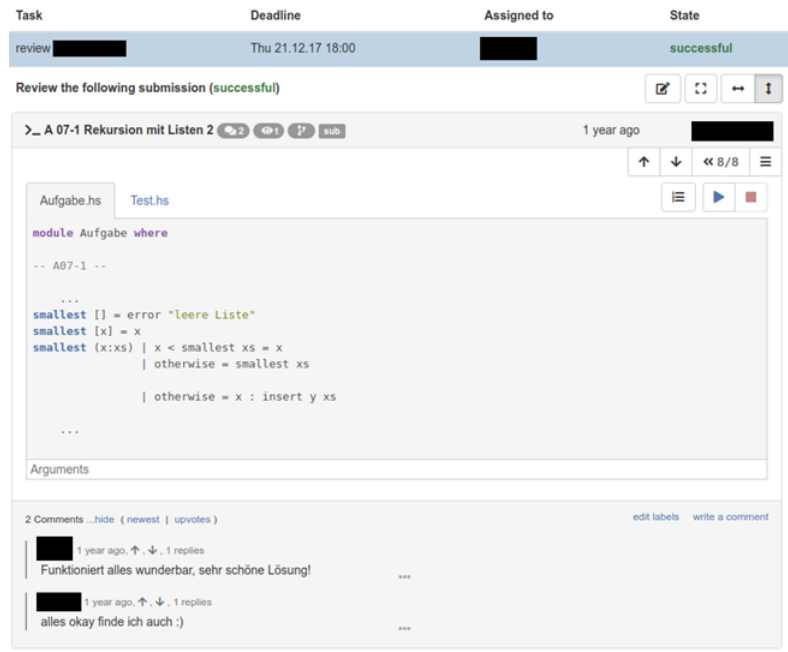
Fig. 1. Screen-shot of the reviewing interface of the platform, with redacted usernames. Top: the submitted homework, bottom: two peer